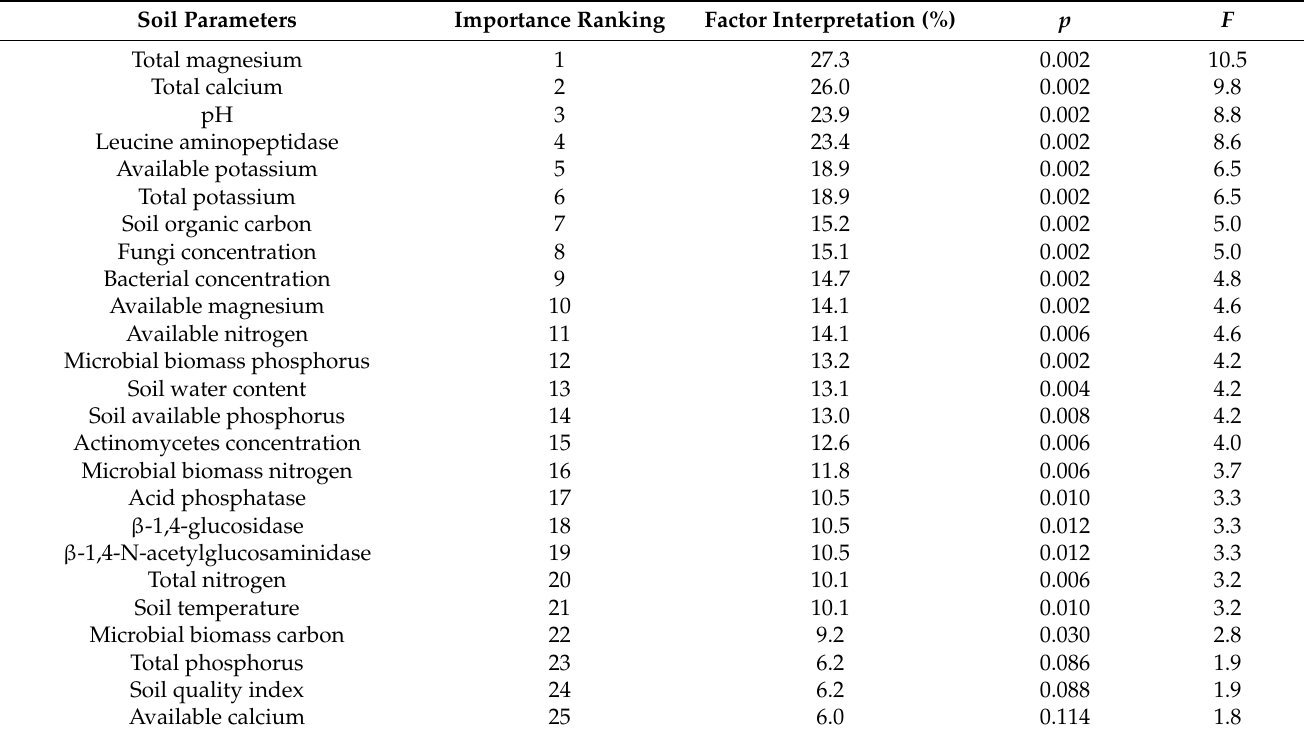
Table 7. Importance ranking and significance test of soil quality